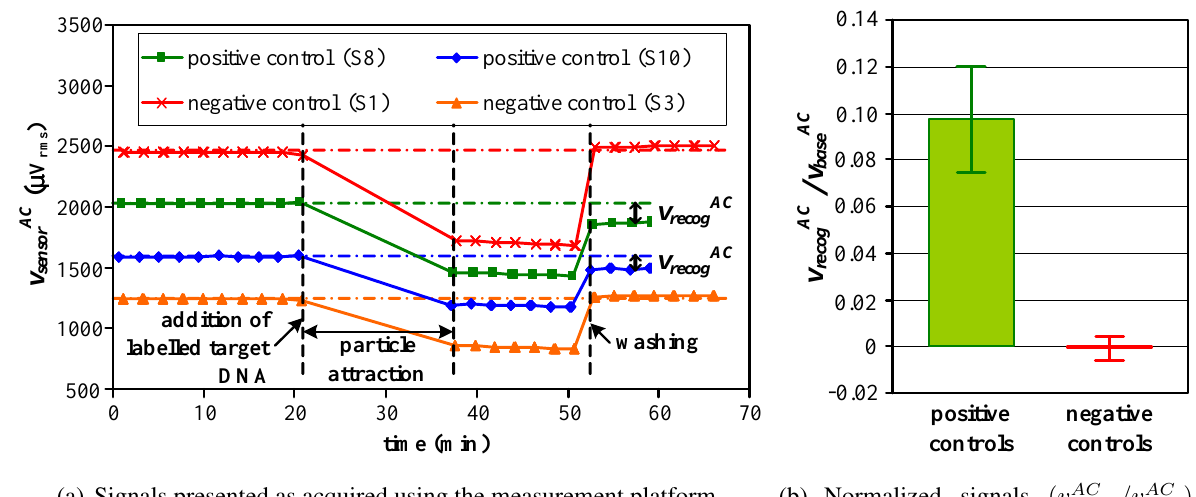
Figure 11. Magnetic detection of DNA-DNA biomolecular recognition using the portable